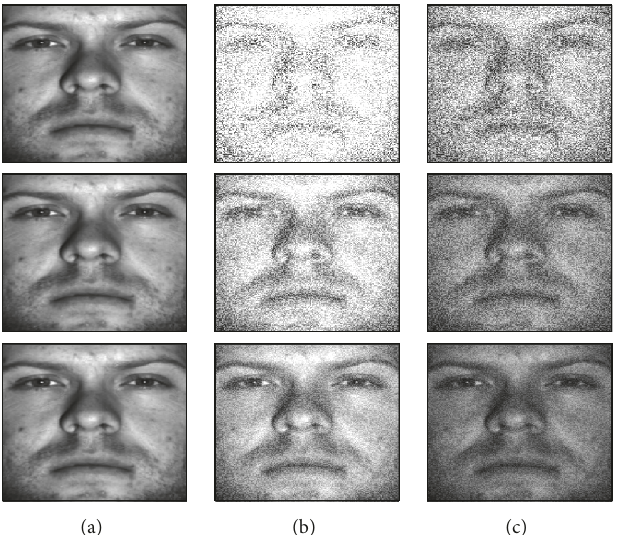
Figure 11: Face image denoising. (a) Original face images. (b) Noisy images. (c) Denoised faces using our proposed algorithm.